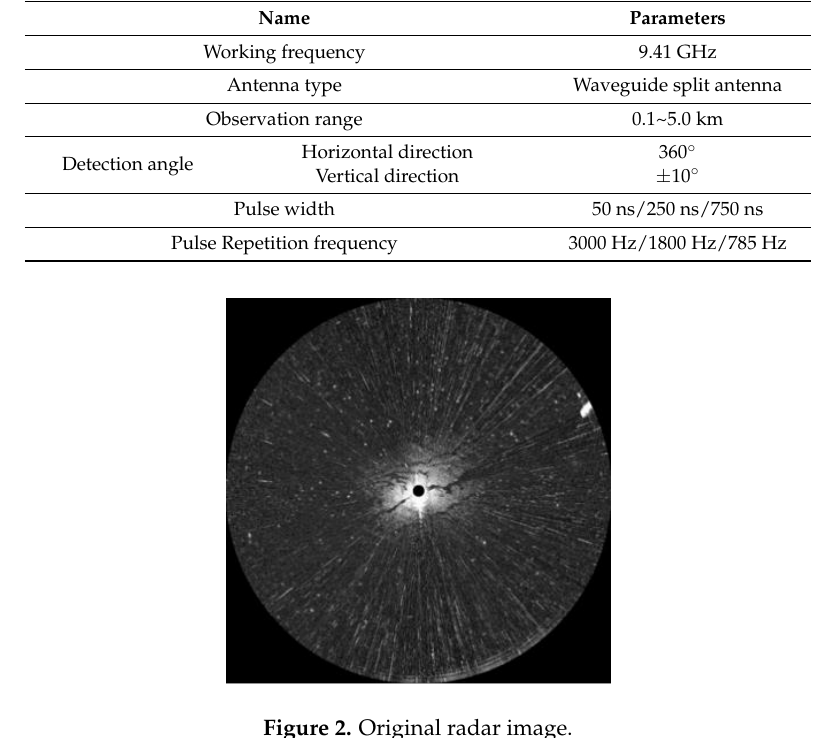
Figure 2. Original radar image.